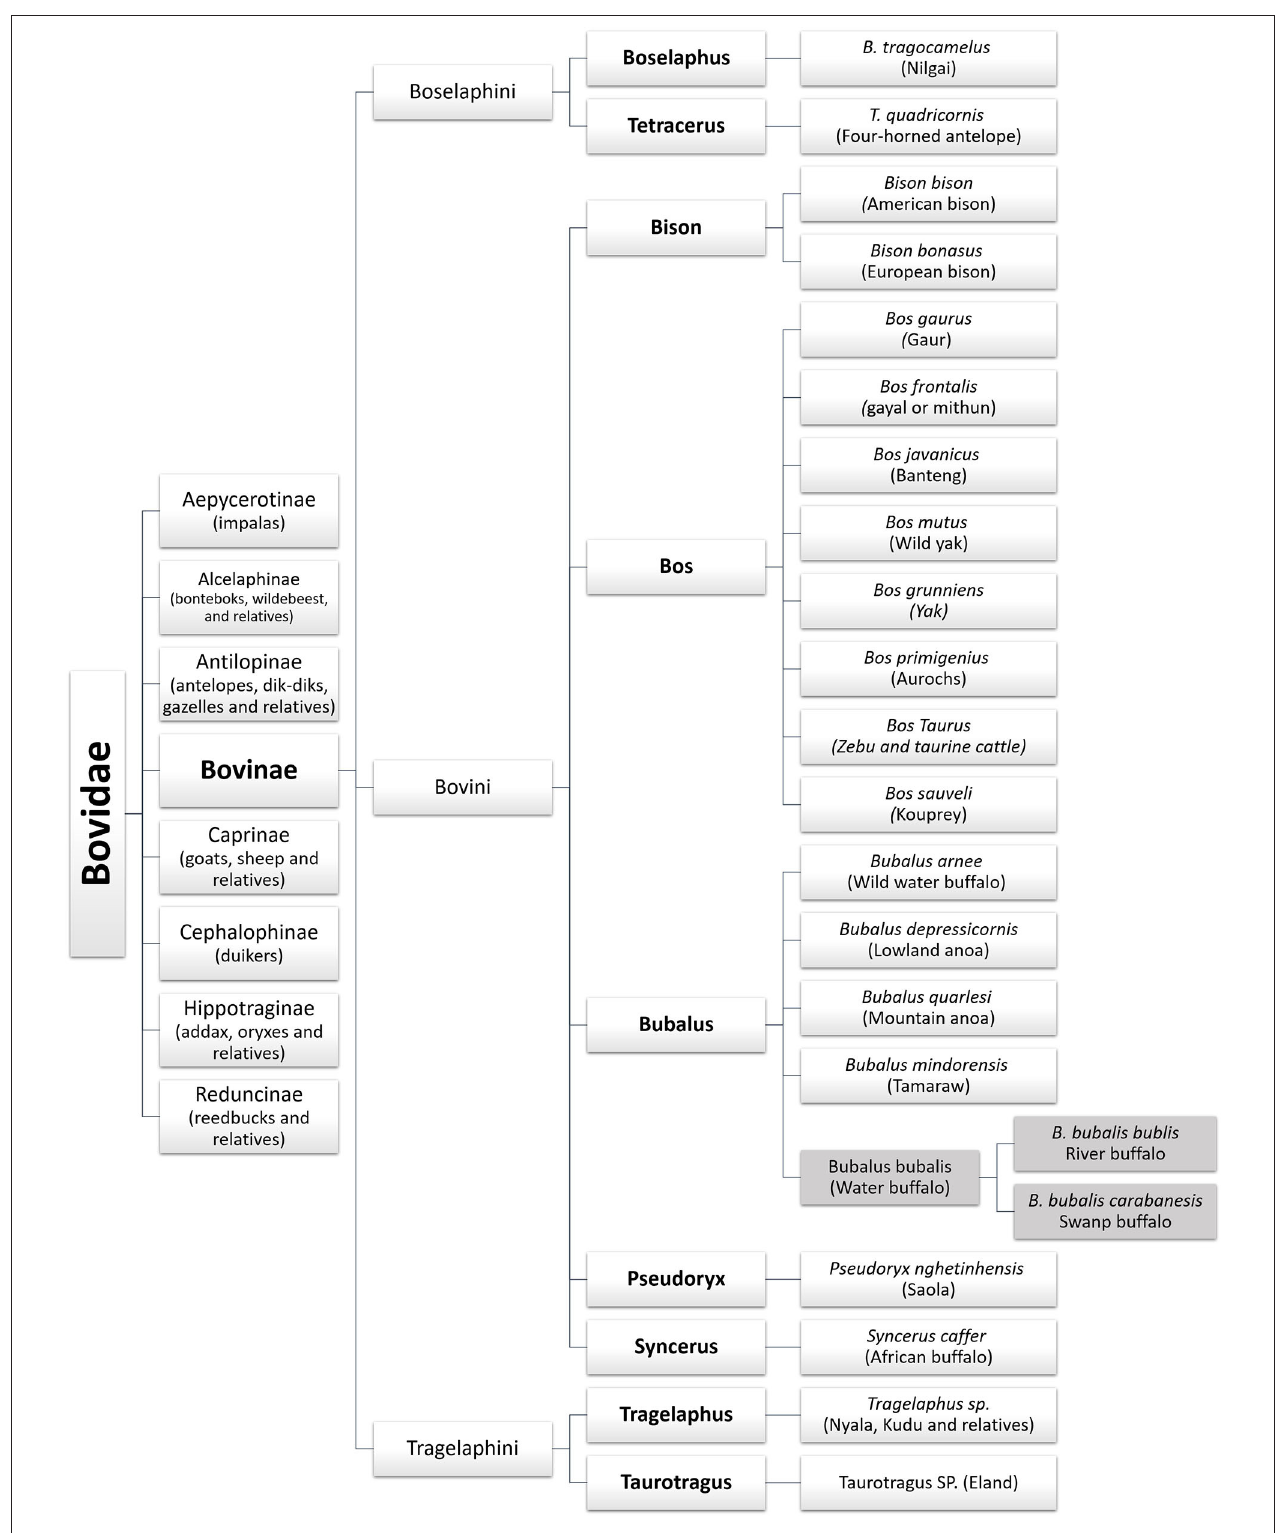
FIGURE 1 | Zoological classification of the water buffalo in the Bovinae family.